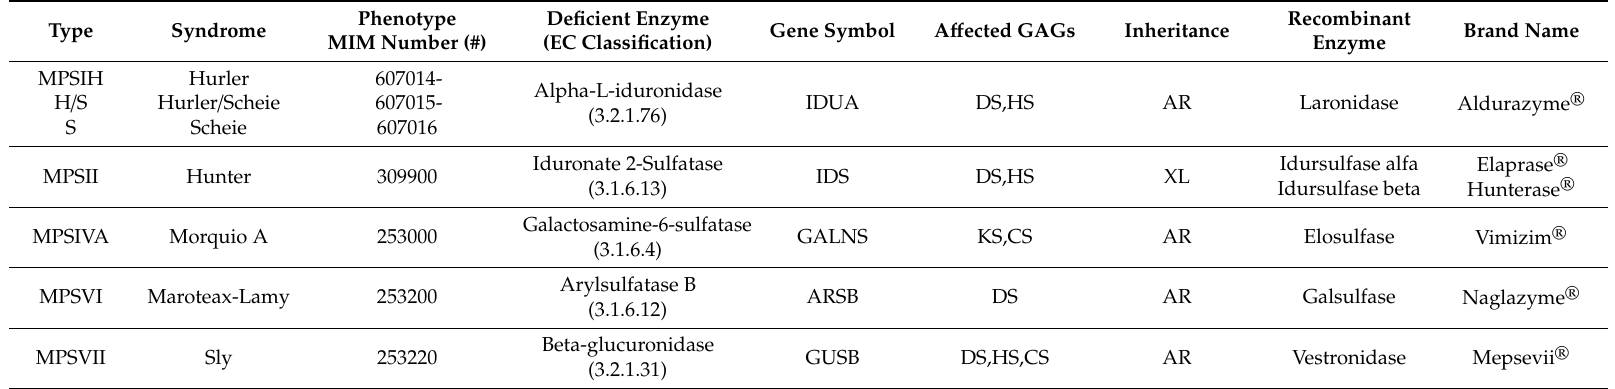
Table 1. Classification of mucopolysaccharidoses (MPSs) with types, syndromes’ names, phenotype Mendelian Inheritance in Man (MIM) number (#), deficient enzymes with their Enzyme Commission (E.C.) classification, gene symbol, a ff ected glycosaminoglycans (GAGs) (DS = dermatan sulfate, HS = heparan sulfate, KS = keratan sulfate, CS = chondroitin sulfate) inheritance (AR = autosomal recessive; XL = X-linked), names of recombinant enzymes and their commercial name. Data obtained from Online Mendelian Inheritance in Man ® (OMIM ® ) https: // www.ncbi.nlm.nih.gov / omim. Accessed on 7 April